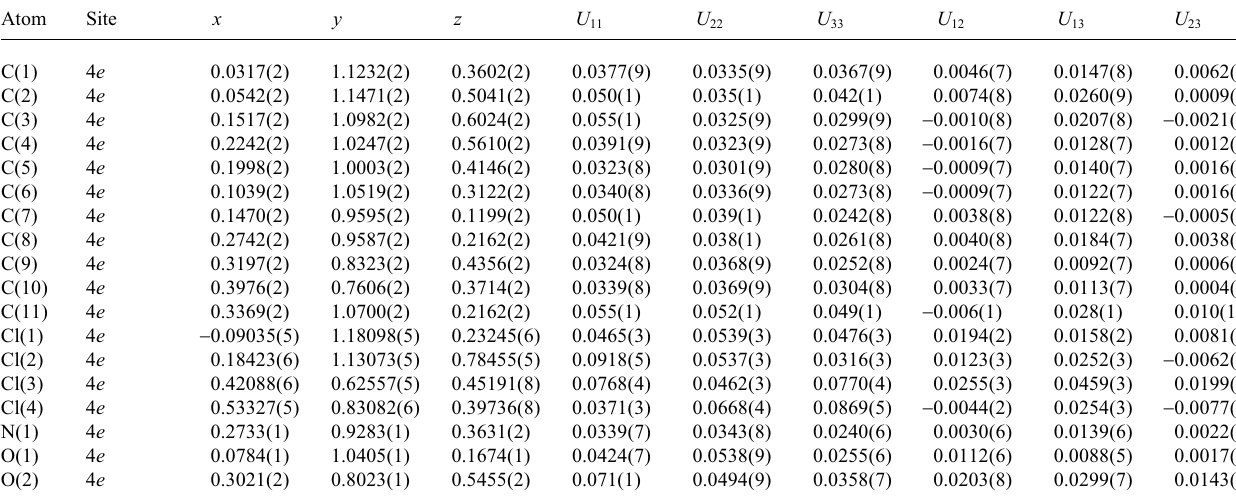
Table 3. Atomic coordinates and displacement parameters (in Å 2 )